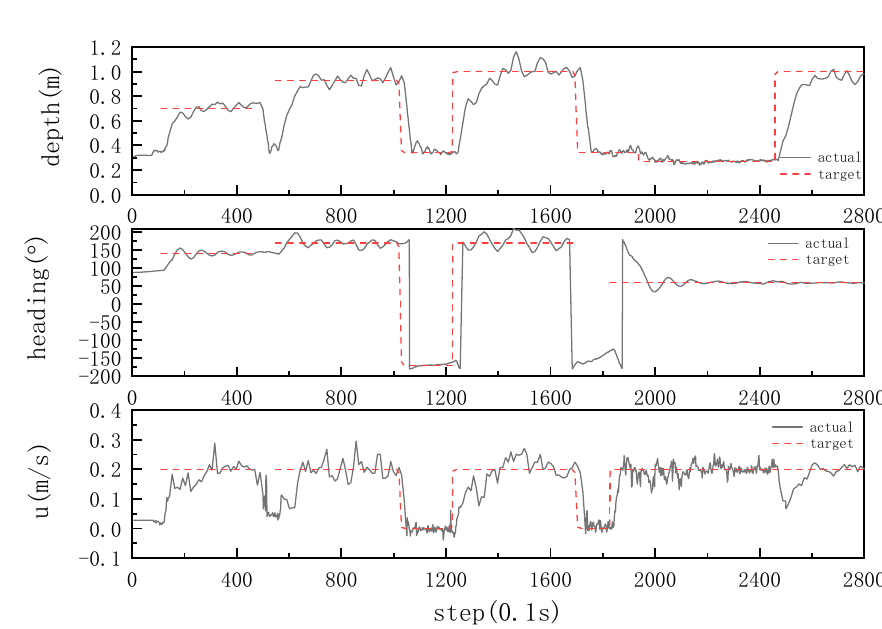
Figure 18. Vertical plane motion automatic control.